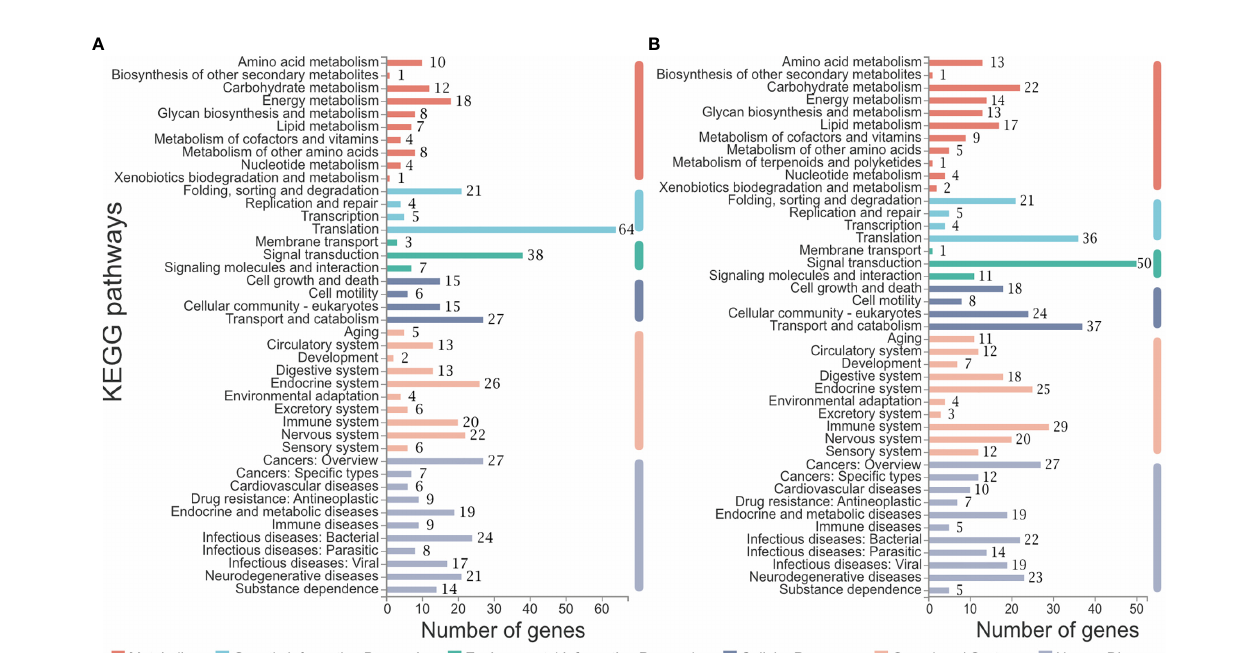
FIGURE 5 | Pathway analysis of CL6 and CL7. (A) Pathways constituted in CL6; (B) Pathways constituted in CL7. The number of genes belonging to each pathway are labeled on the right of the